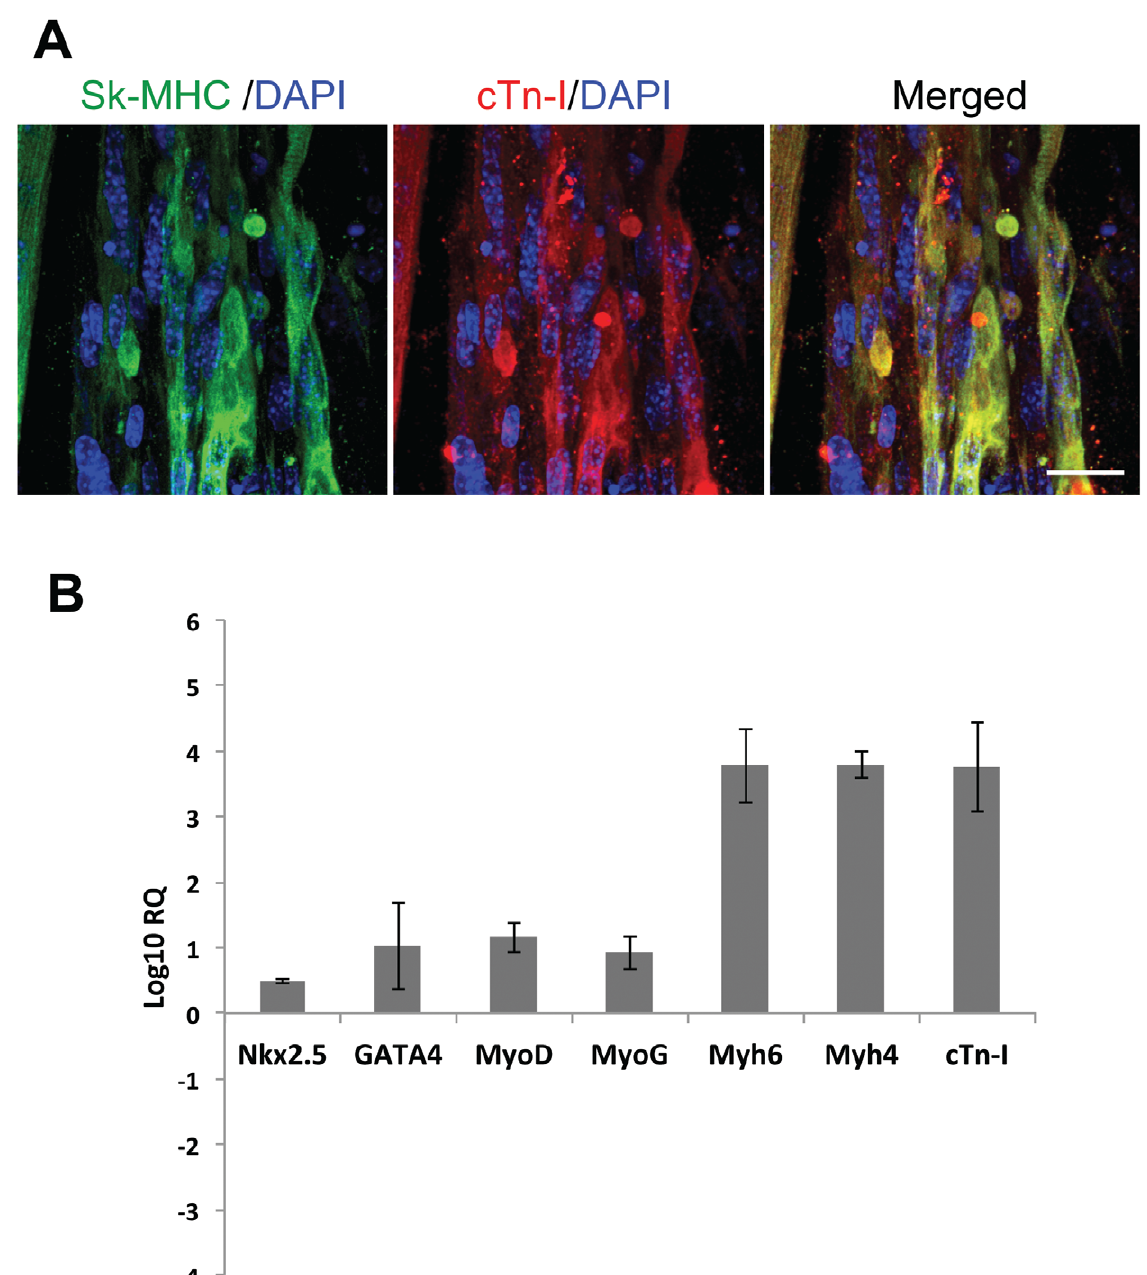
Figure 1. sk-fMHC (green color) and cardiac troponin-I (red color) expression (Panel A) and gene expression (Panel B) of skeletal muscle derived stem cell 3D collagen gel bioreactor (MDSC-3DGB). MDSC-3DGB showed co-localized expression of sk-fMHC and cardiac troponin I. Transcription factor and structural gene expression was increased compared to 2D undifferentiated MDSCs. Scale in panel A indicates 20 m